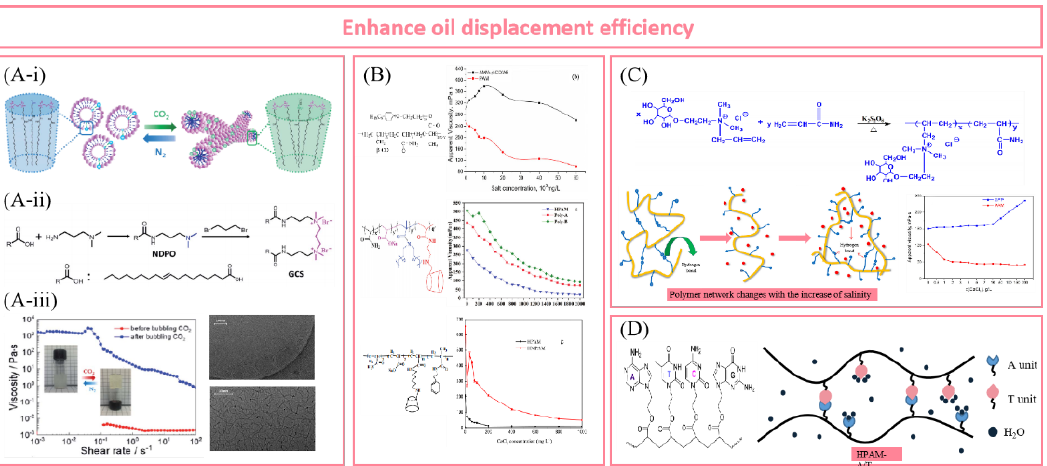
Figure 9. Display of the application of the supramolecular polymers in enhancing oil displacement efficiency. ( A ) A CO 2 -responsive smart system based on the charge transition of the hydrophilic head of a single-chain surfactant [148]. ( B ) The supramolecular polymer based on host–guest interaction has the phenomenon of salt thickening [35,37,95]. ( C ) Due to the coordination between hydrogen bond and metal, HPAM with a glucoside unit showed super high salt tolerance [149]. ( D ) Introducing bases into the side chain of HPAM [150].